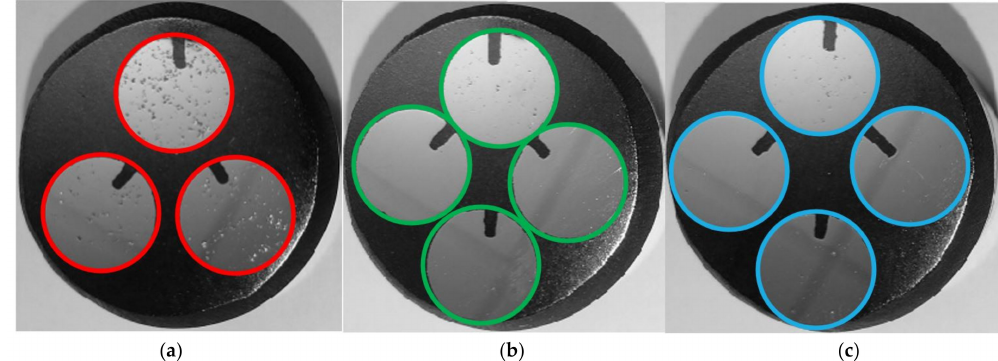
Figure 7. Mounted samples showing different porosity content of specimens belonging to prints 1, 2 and 3, produced with